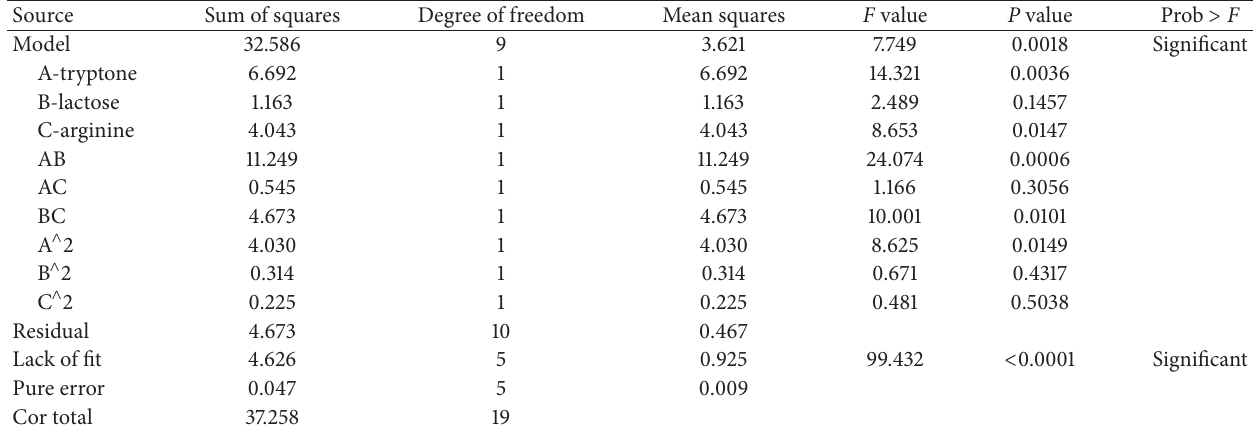
Table 6: Regression analysis (ANOVA) for ADI specific